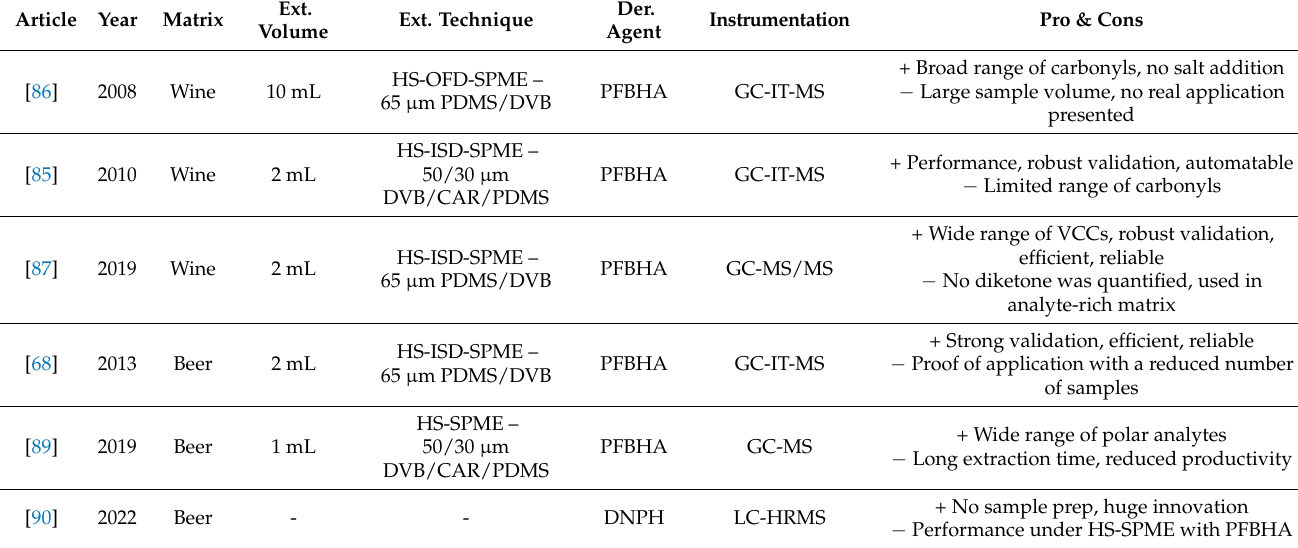
Table 2. GC-MS and LC-MS methods presented for volatile carbonyl determination and related